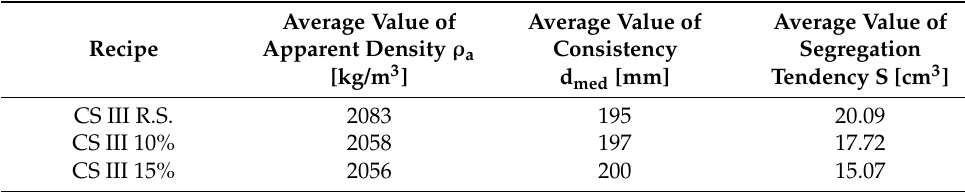
Table 5. Results of tests on fresh